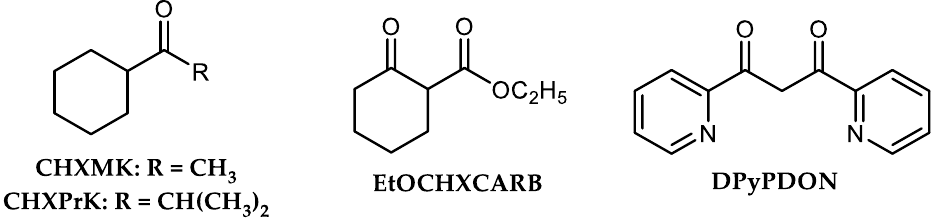
Figure 4. Structures of highly active 1,3-diketone-based ligands [69 – 71].